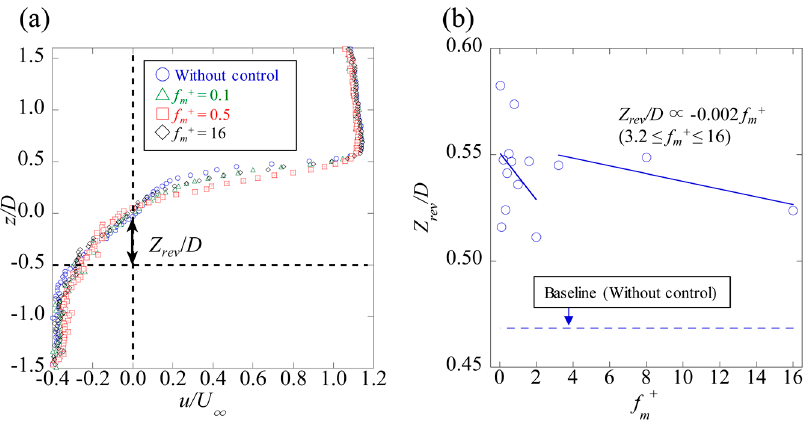
Figure 13. ( a ) Normalized u profiles in the x – z cross section ( y / D = 0) at x / D = 1.25 and ( b ) the height of recirculation region Z rev / D as a function of f m + .